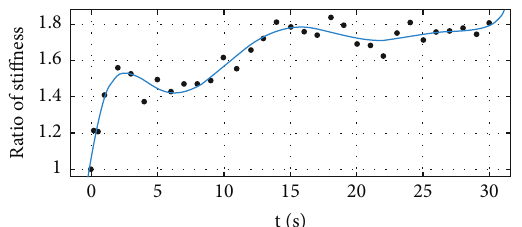
Figure 18: The ratio curve of the sleeper support stiffness.